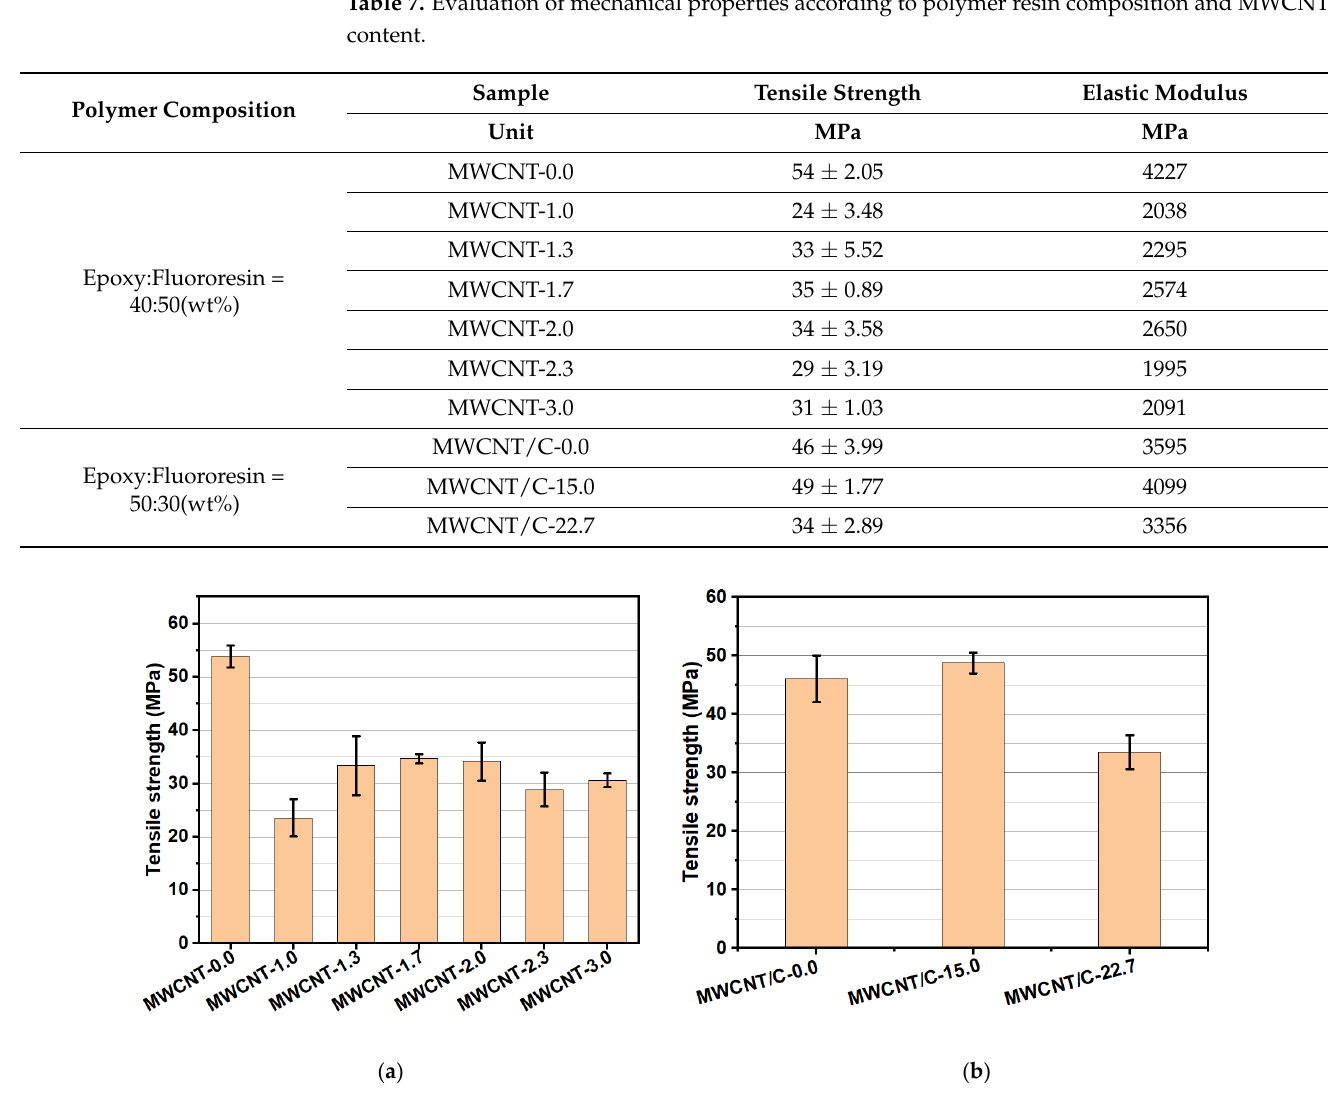
Figure 2. Evaluation of mechanical properties according to polymer resin composition: ( a ) Table 8. CoFs of solid lubricants with different MoS 2 and MWCNT